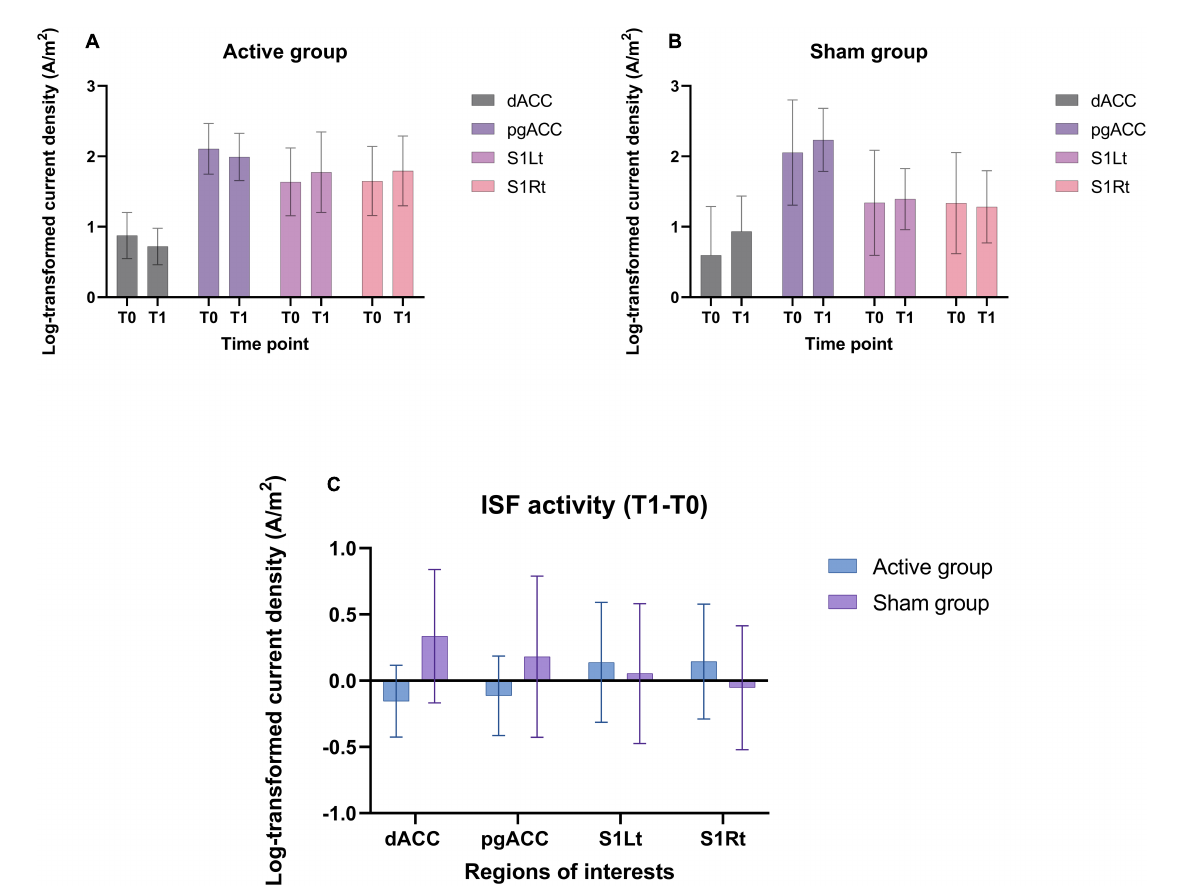
FIGURE7 (A,B) Shows the CSD (mean and standard deviation) of ISF band in different ROIs utilized in this trial for both groups. (C) The mean difference (T1-T0) of CSD of ISF band at the ROIs for both the